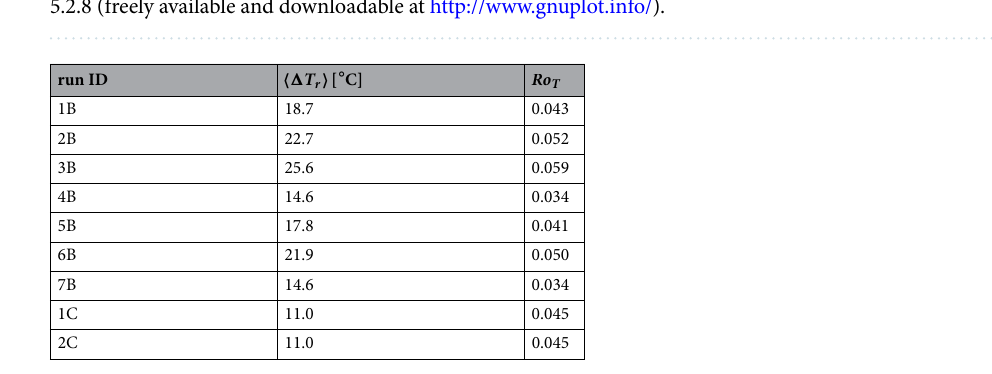
Table 1. The list of experiments. The values of (cid:31) (cid:31) T r (cid:30) represent the temporal average temperature differences between the inner and outer walls (transients are omitted). Experiment IDs ending with B and C denote runs conducted in the Budapest and Cottbus tanks, respectively. The value of the Taylor number for the Budapest 8 9 tank is Ta B = 4.05 × 10 and for the Cottbus tank Ta C = 8.26 × 10 in all